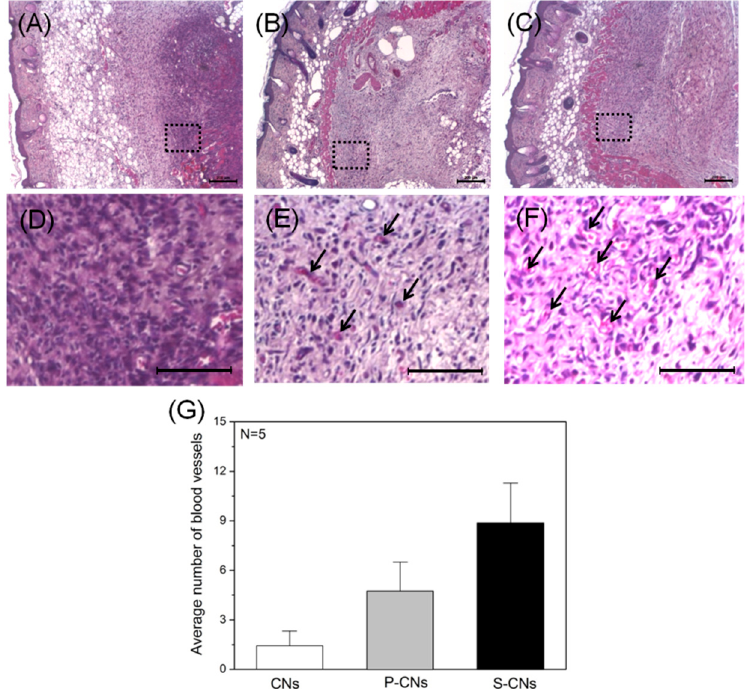
Figure 7. Histological images of implanted CNs H&E-stained after one week. ( A – C ) Images of neutralized CNs ( A ), P-CNs ( B ) and S-CNs ( C ) samples within subcutaneous tissue; ( D – F ) Magnified images of the dotted line regions in ( A – C ), respectively. SP-incorporated samples ( B , C ) showed weaker foreign body reactions (FBRs) and larger numbers of blood vessels (dark arrows) compared to other samples. Scale bar: 200 μ m; ( G ) Quantitative analysis of blood vessels from ( D – F ).